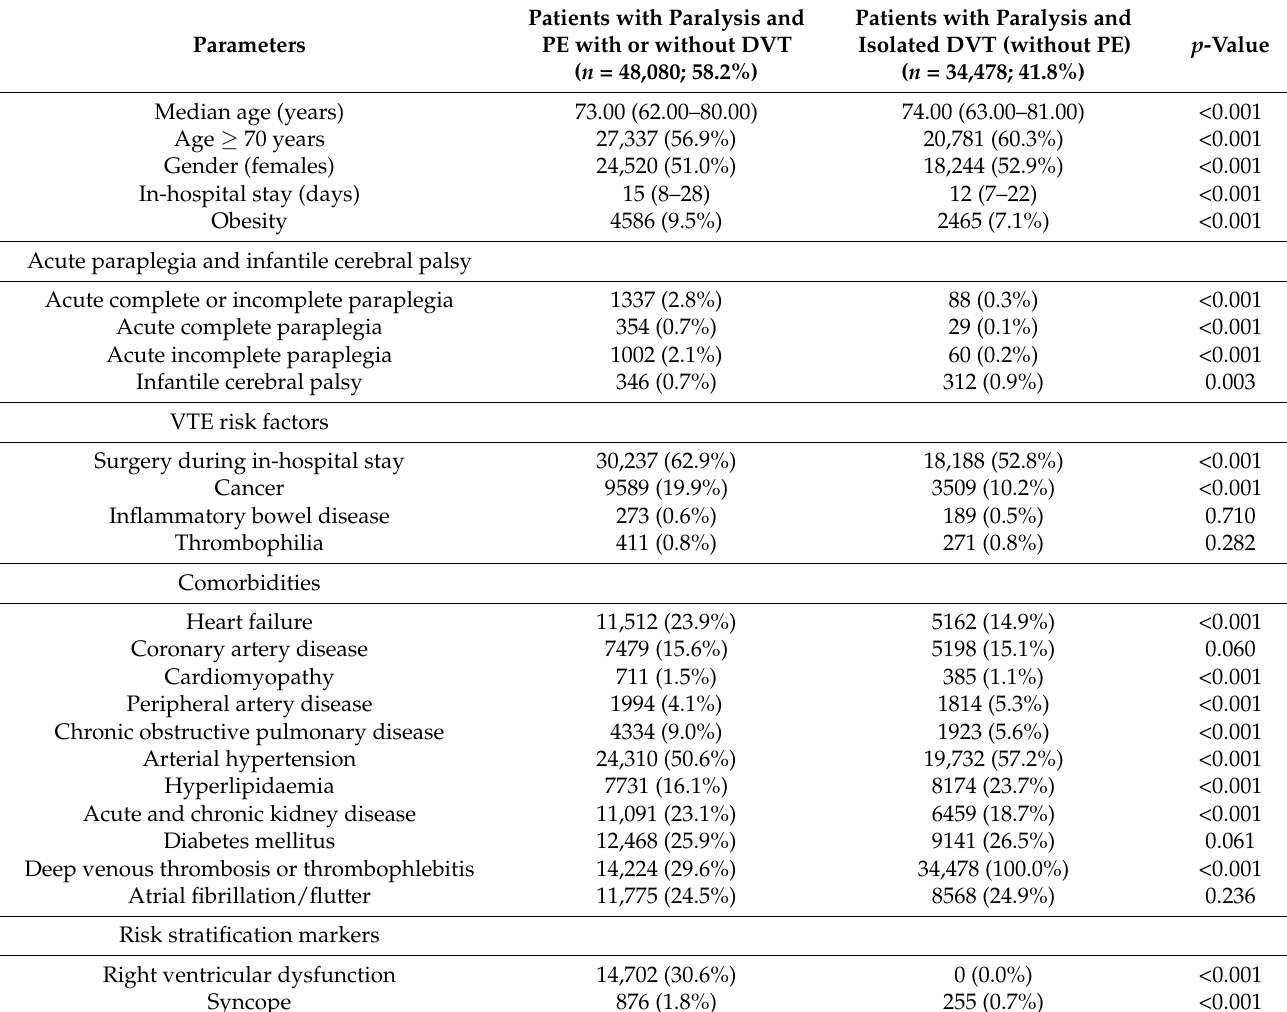
Table 1. Patients’ characteristics, medical history, presentation, treatments and adverse in-hospital events of 82,558 patients with paralysis (ICD codes G80-G83) in co-prevalence with isolated DVT (without PE) (ICD-codes I26, I80, I81, I82) in comparison to patients with paralysis and PE (with or without DVT) (ICD-code I26).